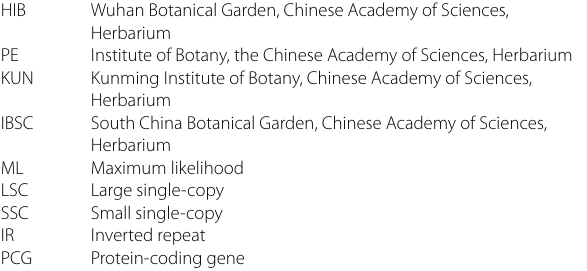
regions: 7 PCGs, 7 tRNA genes, and 4 rRNA genes). Also,